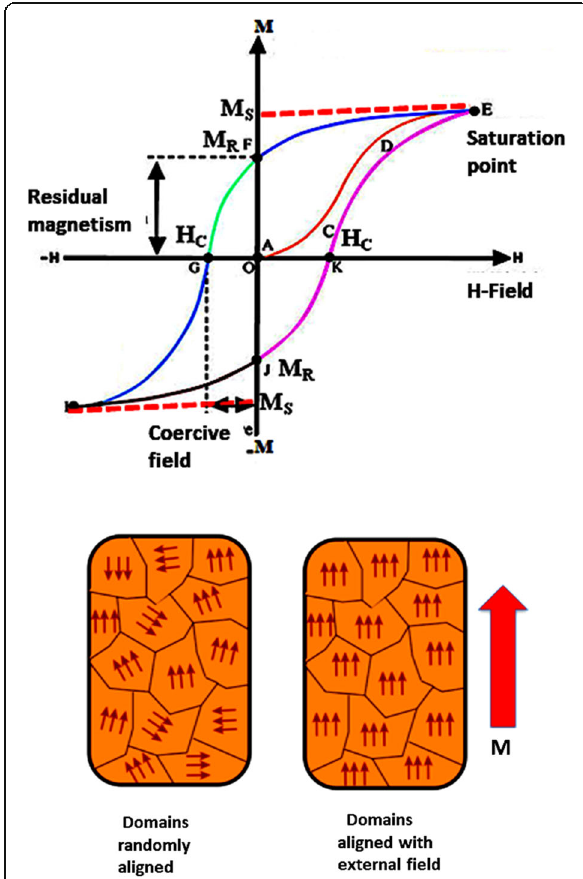
Fig. 1 Ferromagnetic hysteresis loop and effect of magnetic domain alignments on applying magnetic